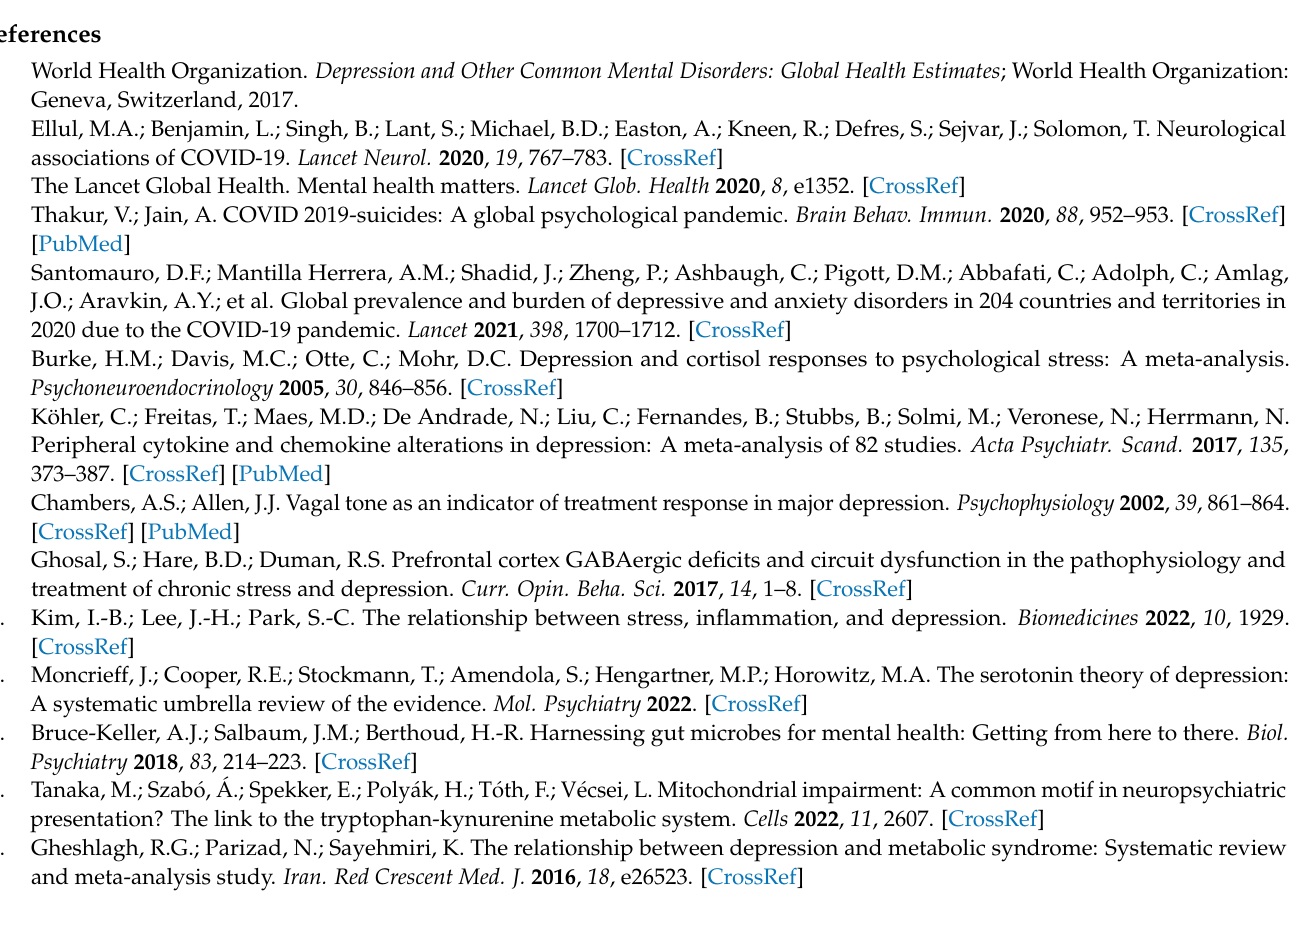
Table S4: Results of taxonomic analysis with Kraken2 and Braken; Table S5: Identified enzymes and their relative abundances in the HC and PwD group; Table S6: Metagenomic signatures identified in the HC and PwD groups; Table S7: Correlation tests for signature pairs; Table S8: Analysis of 276 F. prausnitzii genomes from GeneBank